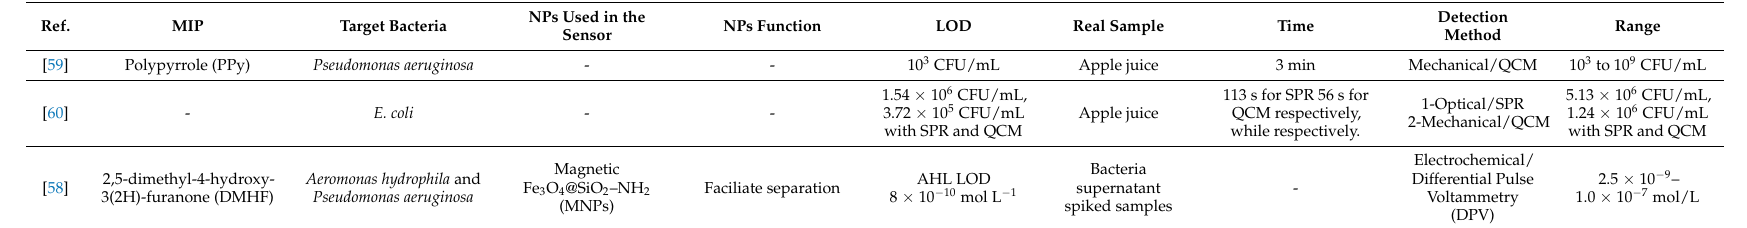
Table 4. MIP-based biosensors for bacteria